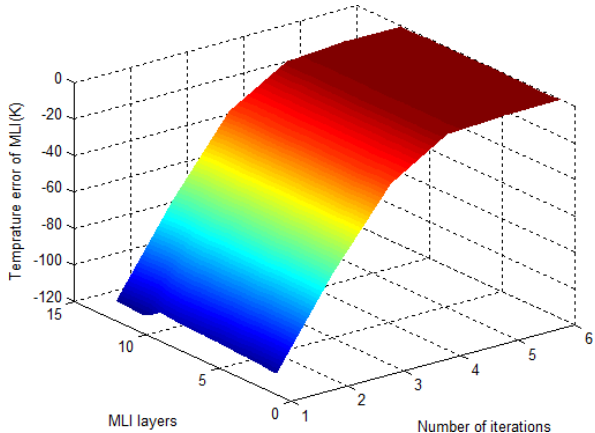
Figure 3. Error of temperature estimation in iterative calculation